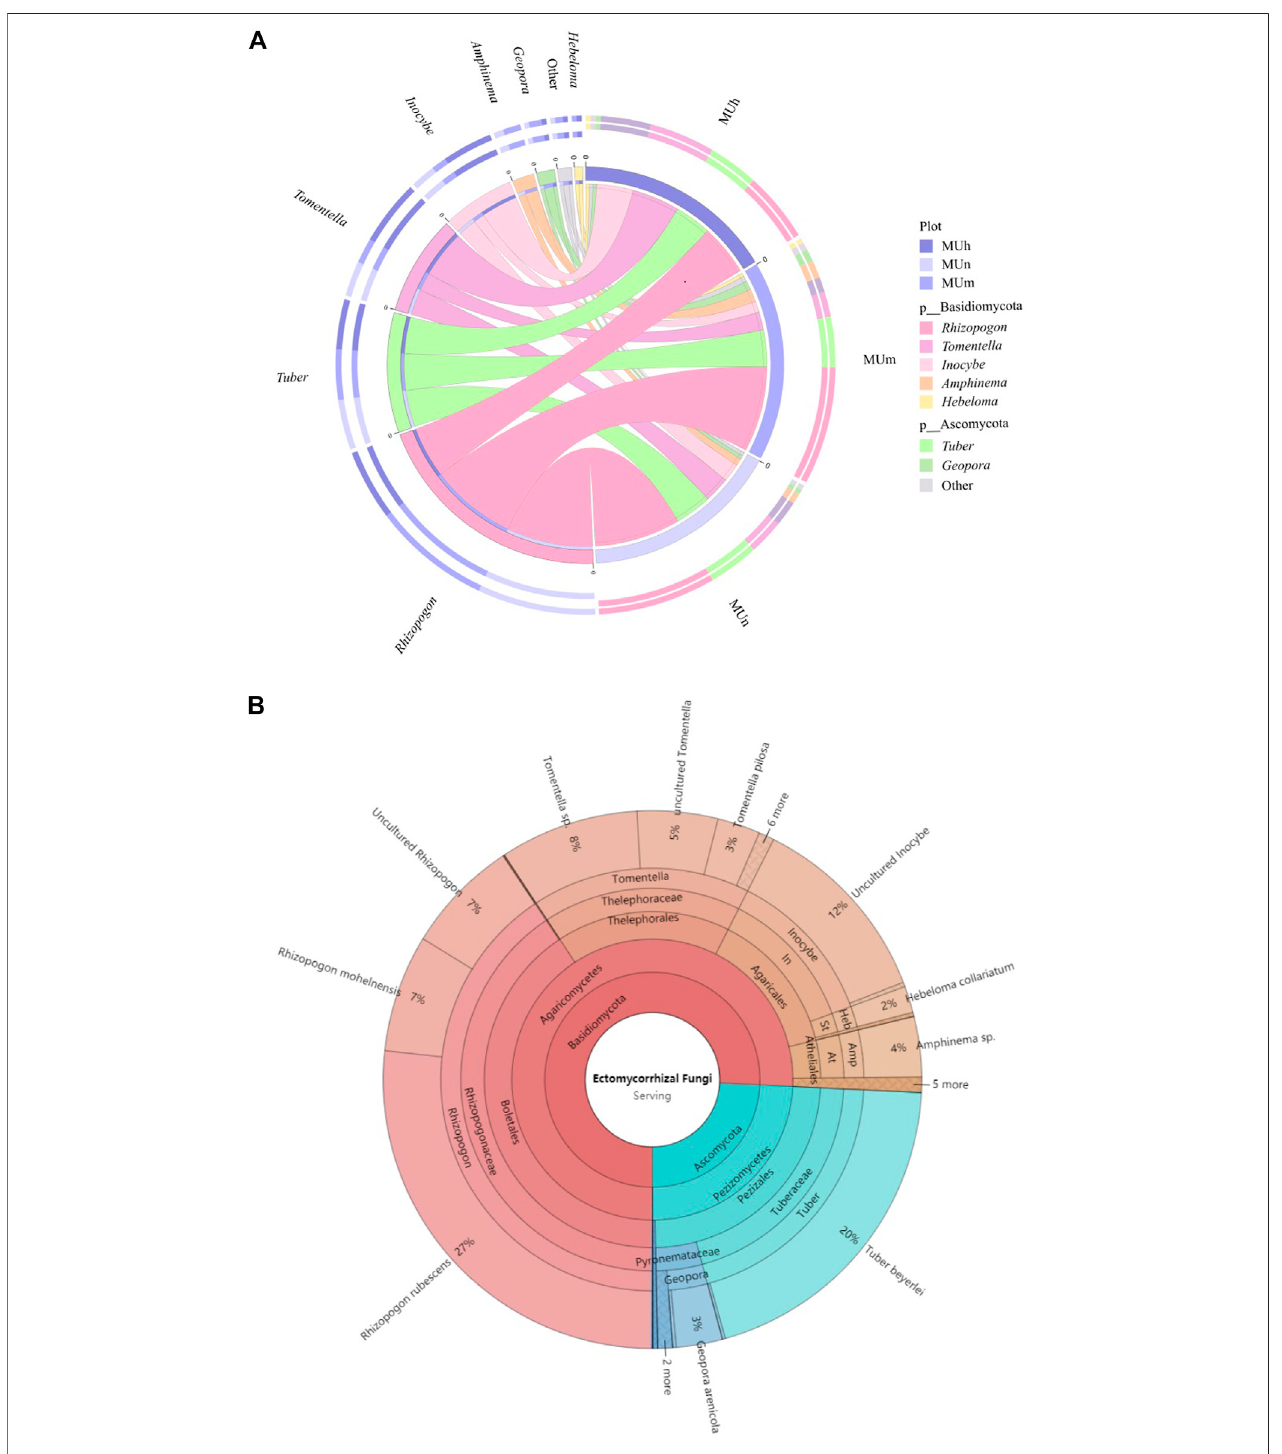
FIGURE2| DistributionandrelativeabundanceoftheEcMfungalcommunityatthegenuslevel (A) andaKronachartoftaxonomicaf fi liationofEcMfungi (B) .Inner circles represent higher taxonomic ranks, and more detailed taxonomic ranks (up to the species level) are presented in outer circles. In: Inocybeceaea , St: Strophariaceae , Heb: Hebloma , Amp: Amphinema of P. sylvestris plantation in three age groups. “ Other ” represents genera with relative abundance < 1%, which are Hygrocybe , Suillus , Cortinarius , Clitopilus , Agaricus , Ramaria , Lactarius , Hydnum , Geastrum , Tulostoma , Peziza , Wilcoxina , Genabea , Sebacina , and Lachnum . The left half of the fi gure shows the relative abundance of EcM fungal genera in different plots, and the right half shows the relative abundance of different EcM fungal genera in the sample plot.